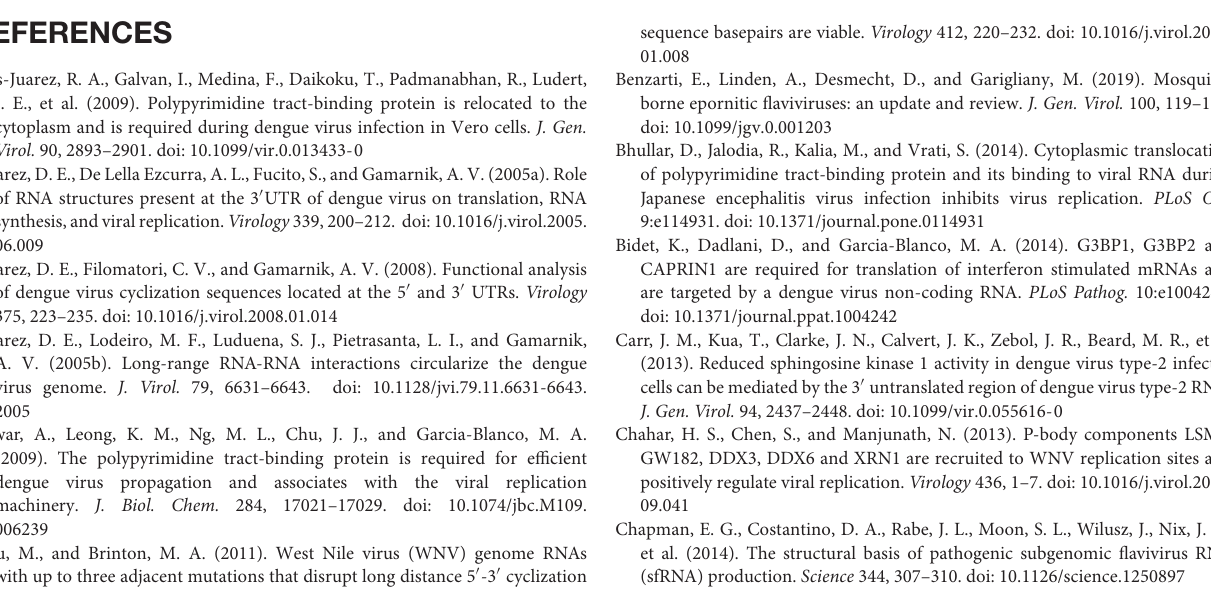
FIGURE S1 | (a) Linear models of MBFV cis- acting RNA and the RNA-acting binding proteins (RBP) for MBFV. Using JEVG as model, the proposed secondary structures of the core cis- acting RNA represent the typical MBFV genomic RNA. Meanwhile, the conformations of individual cis- acting RNA secondary structure are annotated. (b) Summary of the representative MBFV 5 (cid:48) -3 (cid:48) cirRNA models. The minimum-free-energy structure is adopted. Colored lines indicate the interacting RNA elements involved in genome cyclization. The same color is used for equivalent structures in different MBFVGs. FIGURE S2 | Comparison of the nucleotide sequences of 5 (cid:48) -3 (cid:48) cirRNA in MBFVs. The different colors denote the indicated inverted complementary sequences. Above the multiple alignments, the secondary structure of JEVG is shown using an arc plot. FIGURE S3 | Sequence and secondary structure of MBFV 5 (cid:48) SLA. (a) Comparison of the nucleotide sequences of the MBFV 5 (cid:48) SLA. The multiple sequence-alignments are annotated according to the homologous structures. The S1/2 and S1/2 (cid:48) are complementary base pairings, and the ( ∗ ) and ( × ) markers represent the divergent nucleotides. (b) Annotated homologous RNA secondary structure on 5 (cid:48) SLA across MBFVGs. The red dots and arrow in NTAVG indicate the nucleotide variations and insertion compared to the CQW1 strain, respectively. The RNA secondary structure was predicted online by Mfold (http://unafold.rna.albany.edu/?q = mfold). FIGURE S4 | The conserved patterns of structural homology of dual-DB. Divergent nucleotides of group-specific DBs in dual-DB MBFVGs are mapped. The top panel shows the DB1 pattern, and the bottom panel shows the DB2 pattern. FIGURE S5 | The putative DB homology structure for each MBFV. The RNA secondary structure was predicted online by Mfold (http://unafold.rna.albany.edu/?q = mfold) and was trimmed manually. FIGURE S6 | The proposed conserved secondary structure and sequence motifs within the 5 (cid:48) and the 3 (cid:48) ends of the representative flavivirus genomes. The nucleotide numberings are